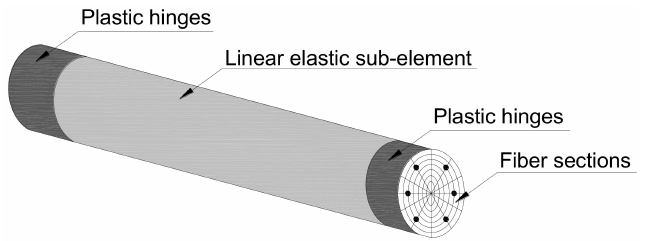
Figure 1. The sketch of the BeamWithHinges element.